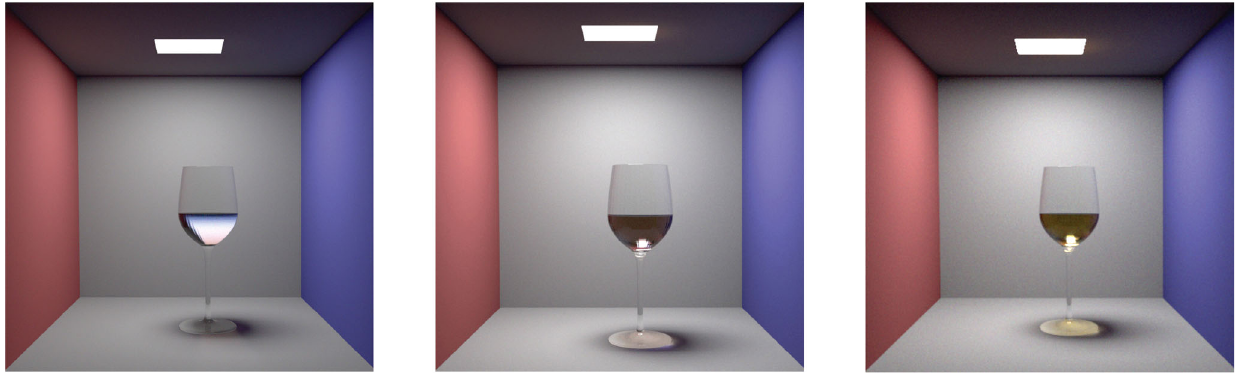
Fig. 8 Rendered images using a physics-based path tracing algorithm. Scattering parameters were manually determined. Left: milk, σ t = (0 . 21 , 0 . 21 , 0 . 21), σ s = (0 . 16 , 0 . 15 , 0 . 15). Center: apple juice, σ t = (0 . 016 , 0 . 027 , 0 . 015), σ s = (0 . 013 , 0 . 015 , 0 . 041). Right: wine, σ t = (0 . 015 , 0 . 027 , 0 . 076), σ s = (0 . 015 , 0 . 021 , 0 . 041). Units: mm − 1 . Gamma curves and exposures of all images were adjusted for